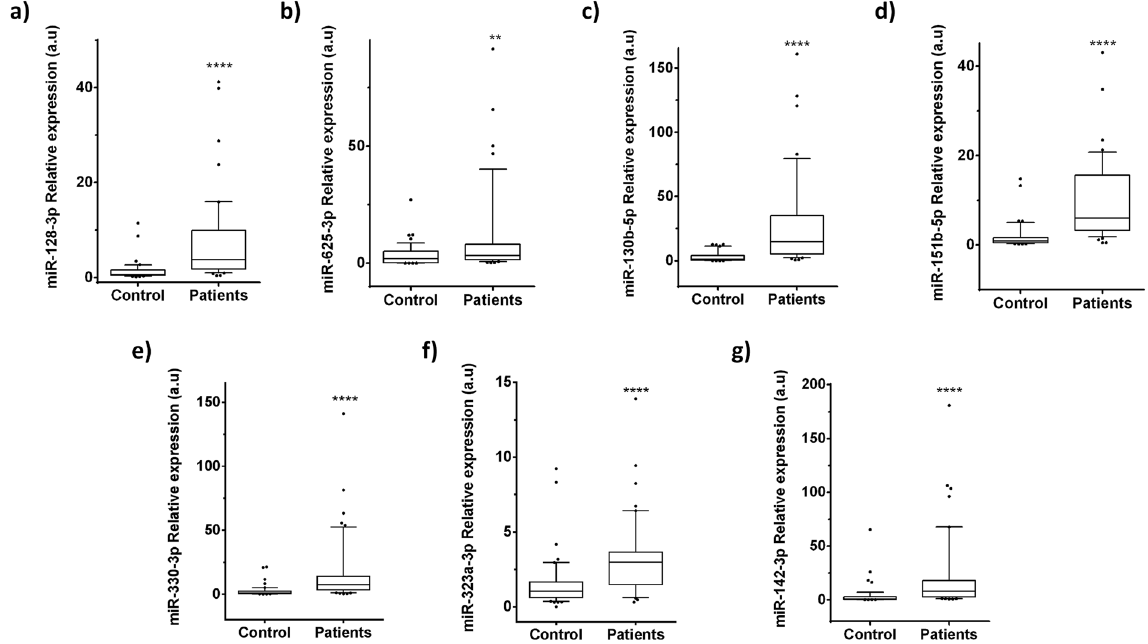
Figure 2. Relative expression levels of the miRNAs with different representation found in plasma of FRDA patients compared to healthy control participants. Box plot of plasma levels of ( a ) miR-128-3p (p < 0.0001); ( b ) miR-625-3p (p = 0.0264); ( c ) miR-130b-5p (p < 0.0001); ( d ) miR-151a-5p (p < 0.0001); ( e ) miR-330-3p (p < 0.0001); ( f ) miR-323a-3p (p < 0.0001); and ( g ) miR-142-3p (p < 0.0001) in healthy participants (Controls) (n = 25) and FRDA patients (n = 25). Expression levels of the miRNAs were normalized to miR-16. The lines inside the boxes denote the medians. The boxes mark the interval between the 25th and 75th percentiles. The whiskers denote the interval between the 10th and 90th percentiles. Filled circles indicate data points outside the 10th and 90th percentiles. Statistically significant differences were determined using Mann-Whitney tests. All P-values were two-tailed and less than 0.05 was considered statistically significant.